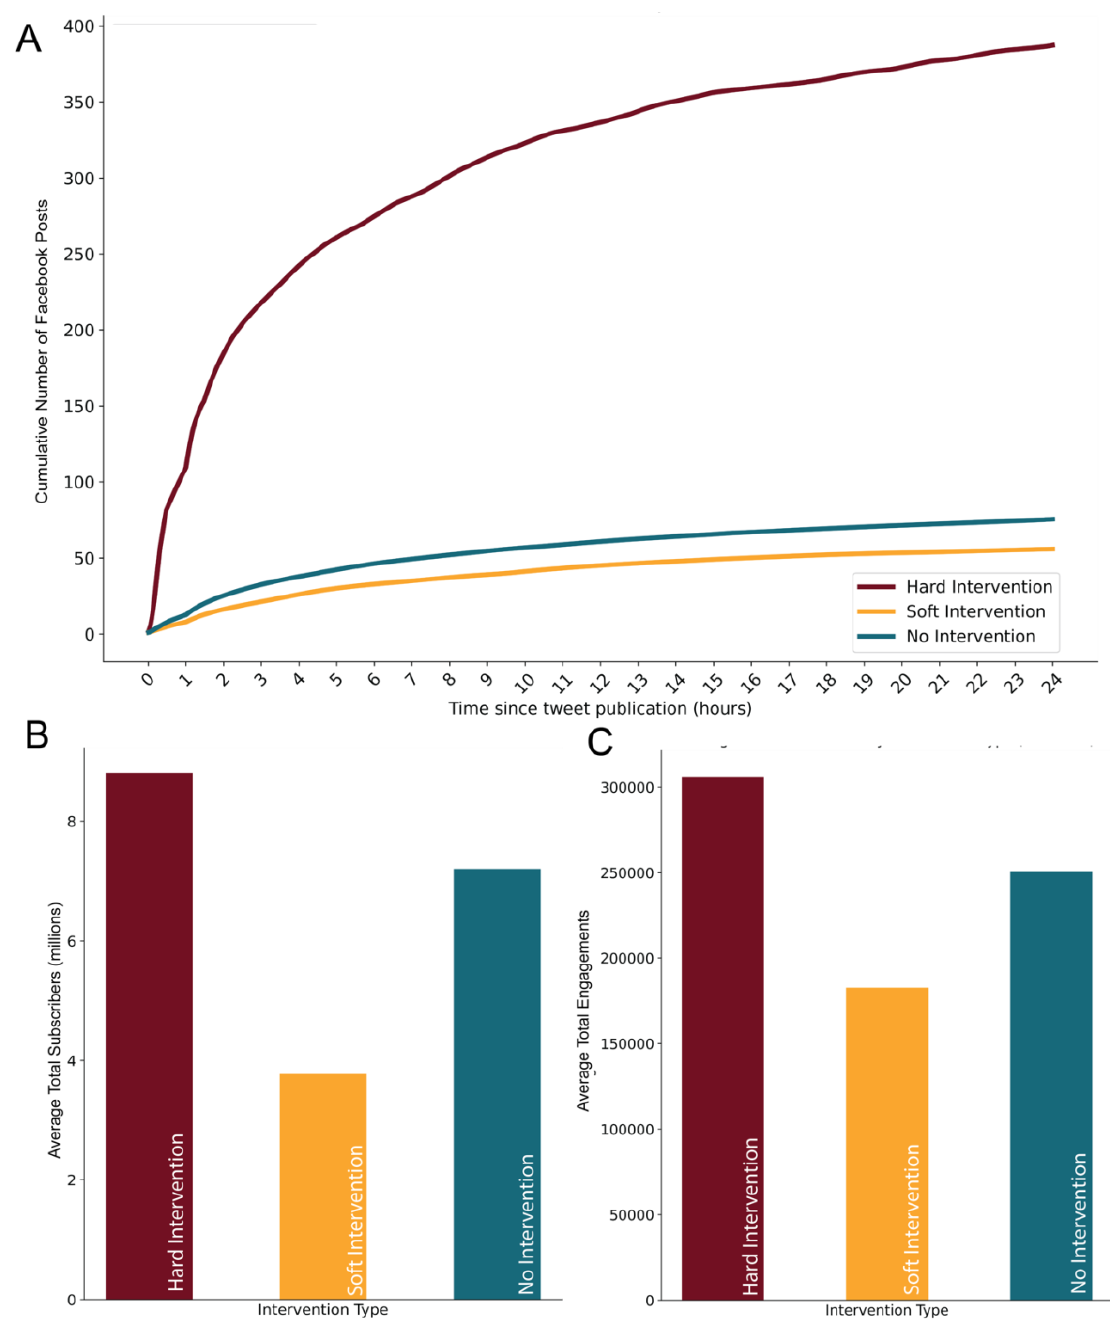
Figure 3 . Trajectory, exposure, and engagement of tweets on Facebook by intervention type. We first group all messages by the type of intervention they received on Twitter (hard intervention, soft intervention, or no intervention). (a) Growth of Facebook posts by intervention: we plot the cumulative number of posts (y-axis) over time (x-axis) averaged over all of the messages in that category. (b) Exposure per post on Facebook by intervention on Twitter: we measure the average number of page subscribers for pages that posted the messages in each category. (c) Engagement per post on Facebook by intervention on Twitter: we measure the average engagement (number of likes or reactions) for messages in each